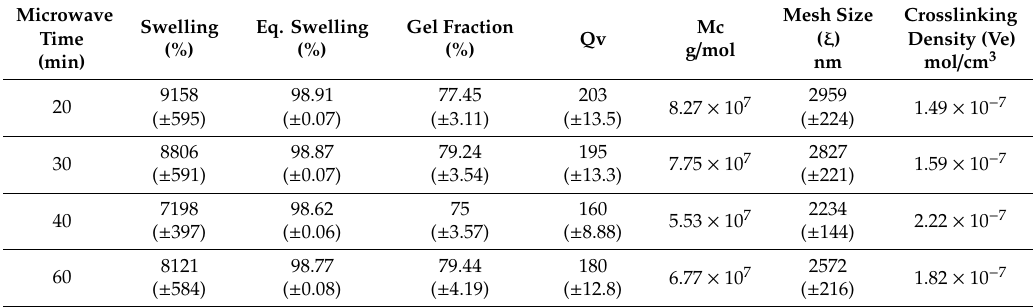
Table 7. Swelling, mesh size, and cross-linking behaviour of HA5-PT30 hydrogels crosslinked by the microwave